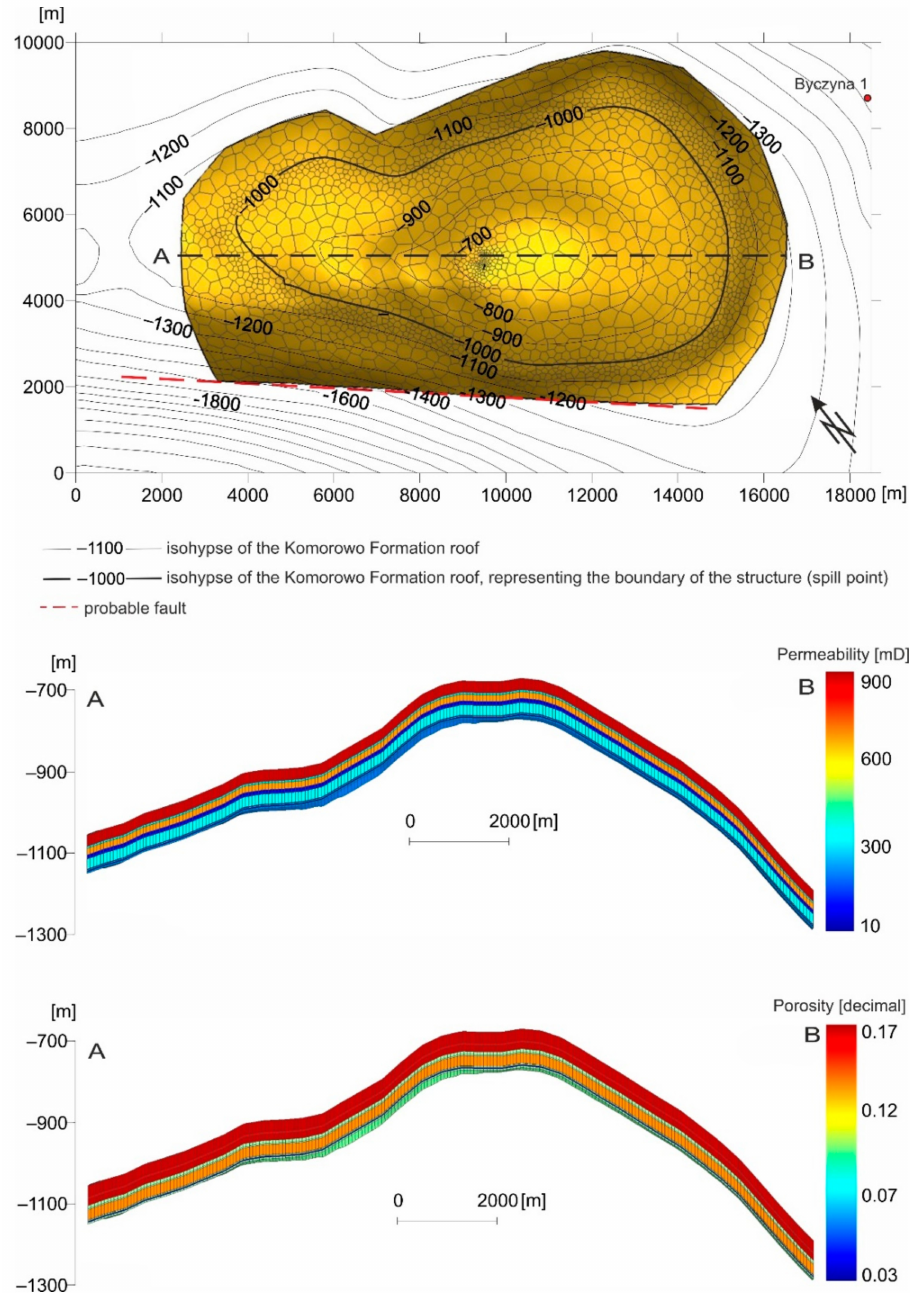
Figure 2. The area selected for modeling against the background of the Konary structural map and the AB cross-sections of the reservoir, illustrating permeability and porosity changes (based on [46] with the author’s